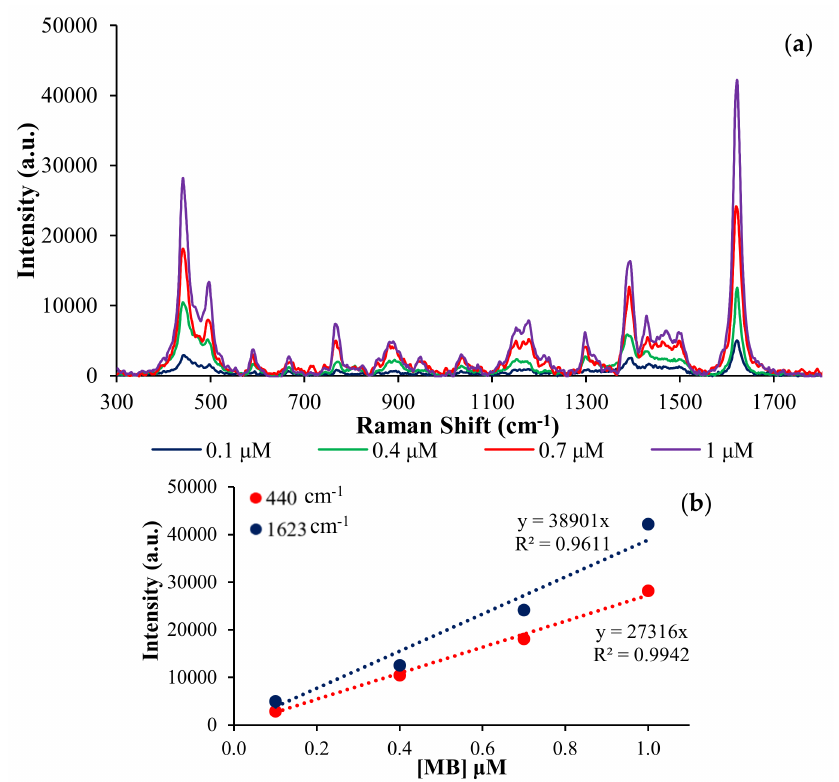
Figure 5. ( a ) SERS spectra of MB with different concentration: 0.1 (blue), 0.4 (green), 0.7 (red) and 1 µ M (violet), using AgNPs-142 as SERS substrate, ( b ) calibration curve of SERS intensity at 440 and 1623 cm − 1 .